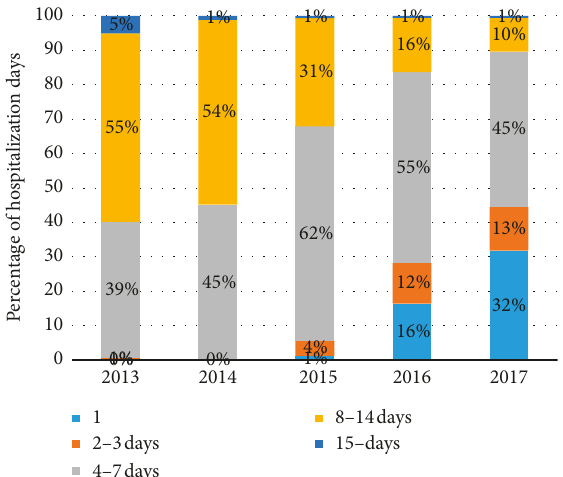
Figure 3: Trend of the changes in the number of days of hospi- talization recorded at the study location over the past five